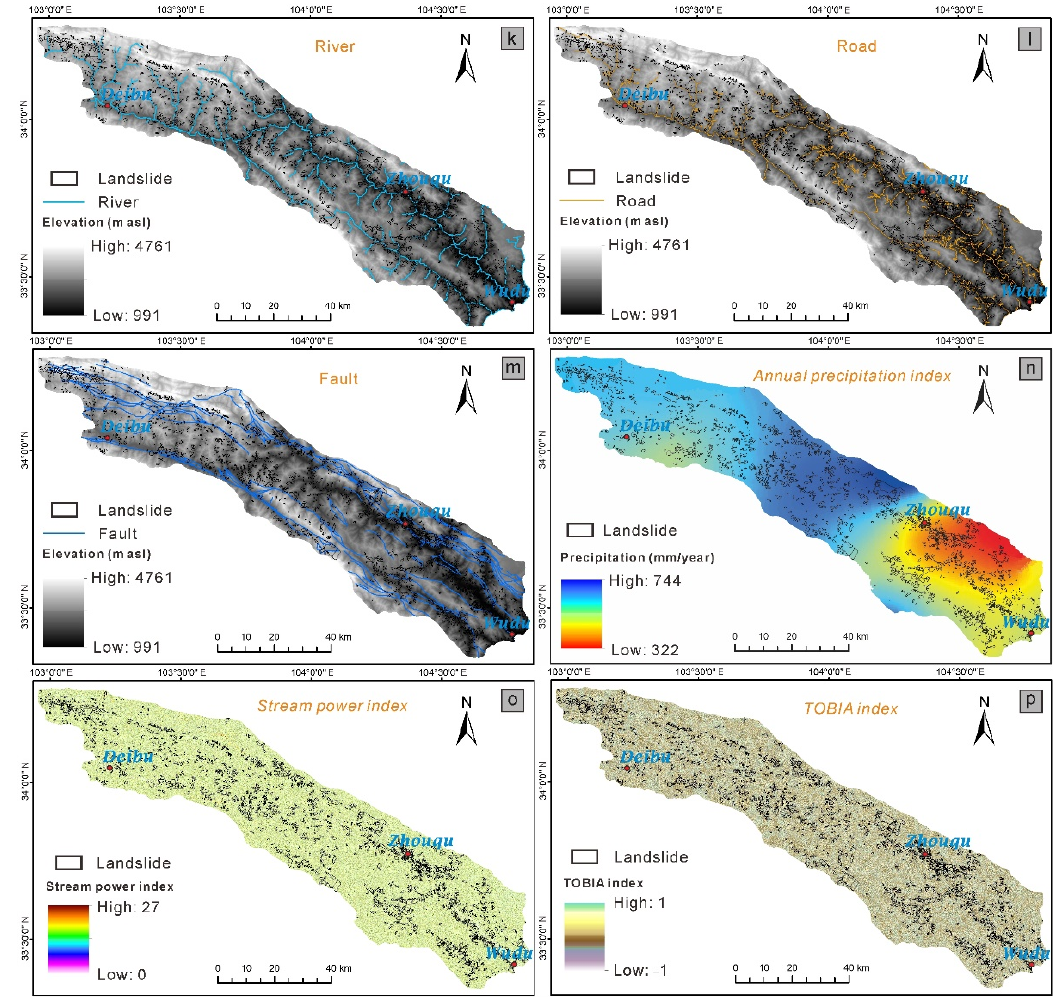
Figure 4. Maps of the model evaluation factors. ( a ) Elevation. ( b ) Slope angle. ( c ) Slope aspect. ( d ) Planar curvature. ( e ) Profile curvature. ( f ) Topographic wetness index. ( g ) NDVI. ( h ) Formation lithological index. ( i ) Soil type. ( j ) Land use. ( k ) River. ( l ) Road. ( m ) Fault. ( n ) Annual precipitation index. ( o ) Stream power index. ( p ) Topographic/bedding-plane intersection angle (TOBIA).